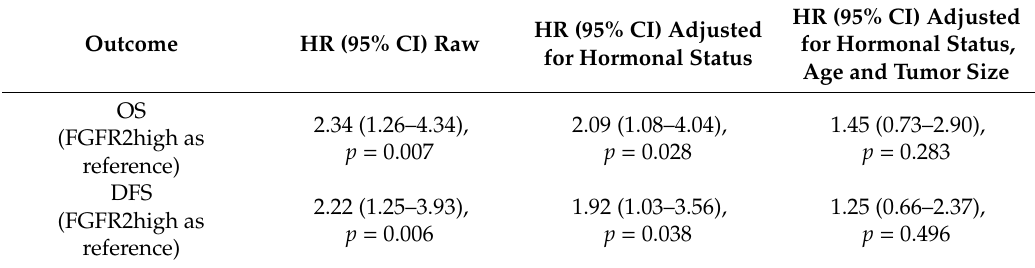
Table 3. Results from Cox multivariate analysis for overall survival (OS) and disease-free survival (DFS) regarding FGFR2 status adjusted for variables significant in the univariate survival